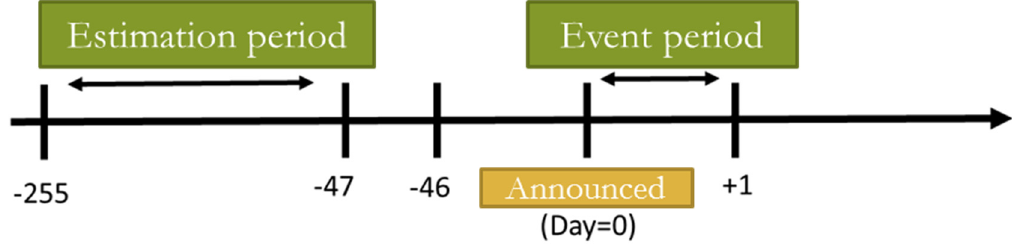
Figure 1. Estimation and Event Periods.